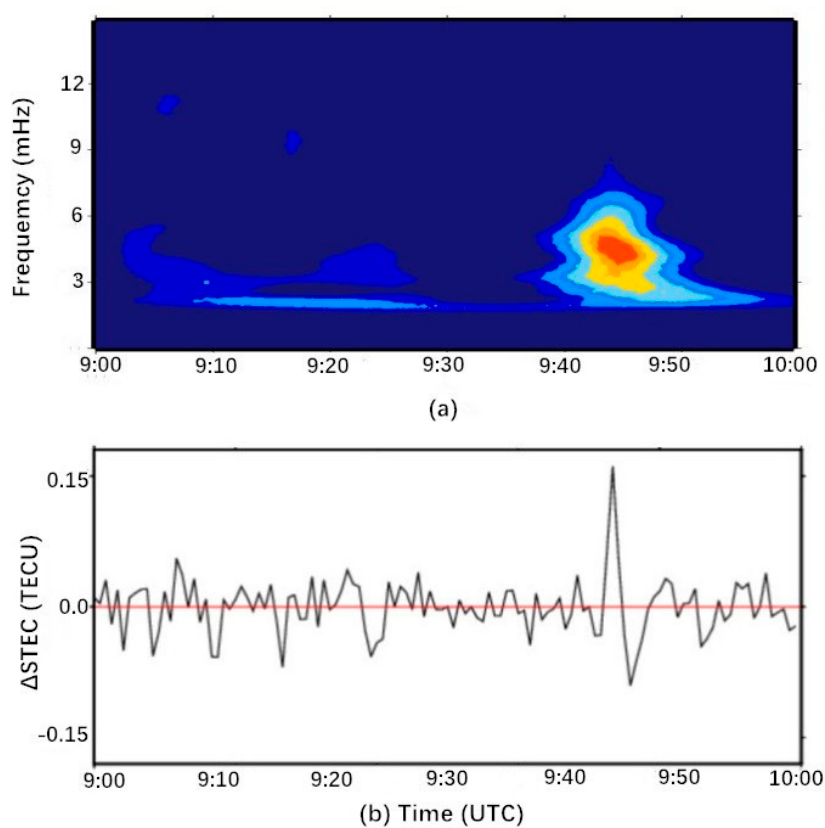
Figure 5. ∆ STEC (slant total electron content) time series in the sight line of av07 station to GPS satellite 05 and the corresponding spectrum during 9:00–10:00 UTC. ( a ) Frequency domain distribution diagram; ( b ) time domain distribution.